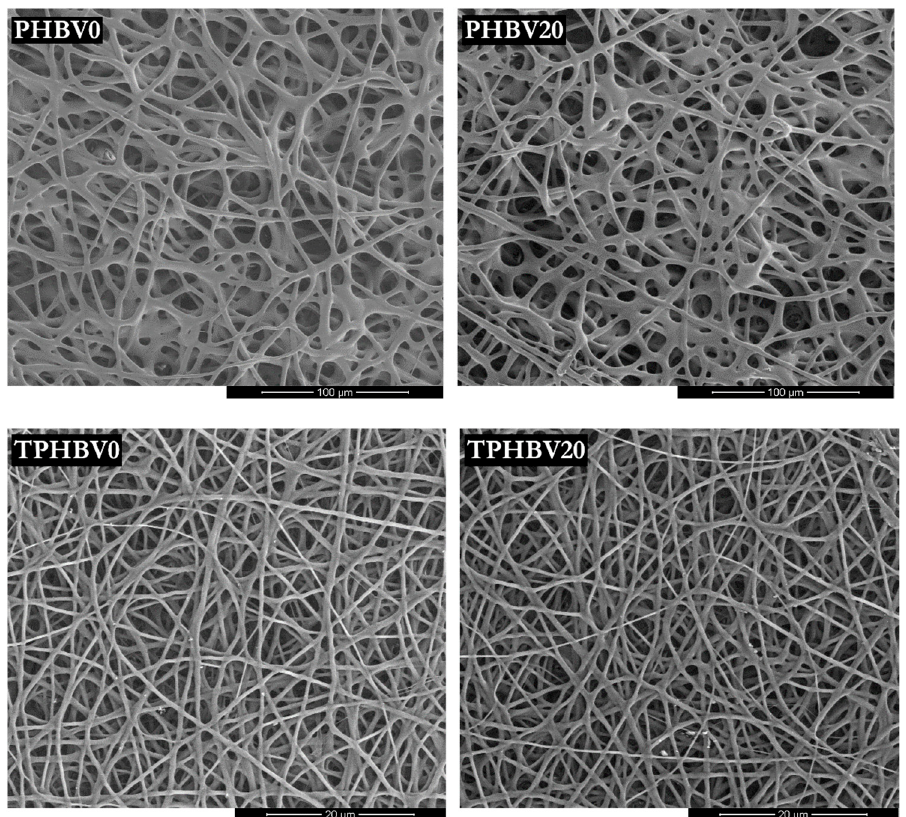
Figure 3. SEM images of the untreated PHBV fibers (TPHBV0 and PHBV0) and the treated ones. The treated fibers shown here correspond to the modification carried out for 20 min at a LiBH 4 concentration of 0.005 mol/dm 3 . The modified fibers with a mean diameter of 0.74 ± 0.20 µ m are denoted as TPHBV20, while the treated fibers of a larger diameter (3.75 ± 0.67 µ m) are denoted as